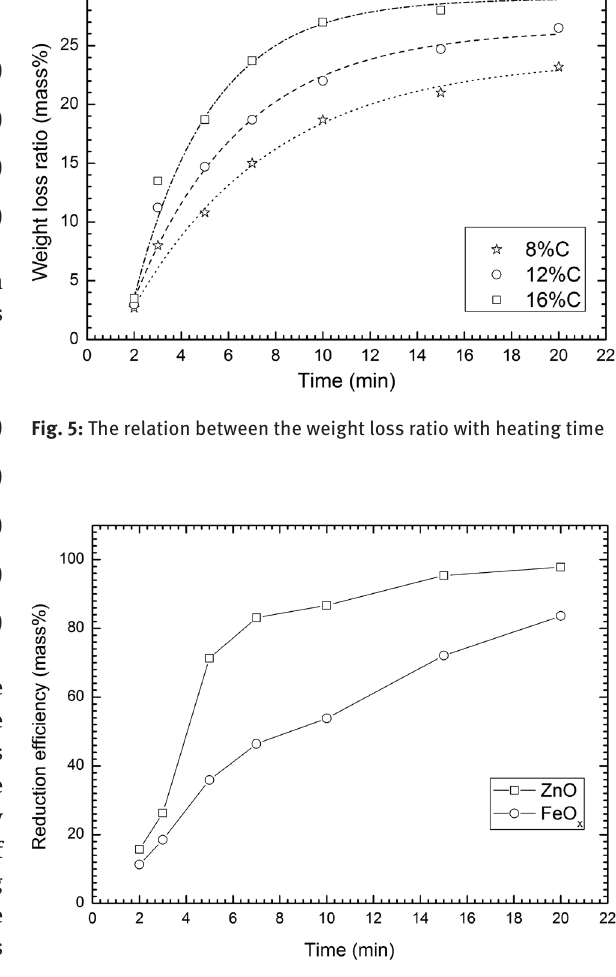
Fig. 6: The relation between the reduction efficiencies of ZnO and FeO x with heating time